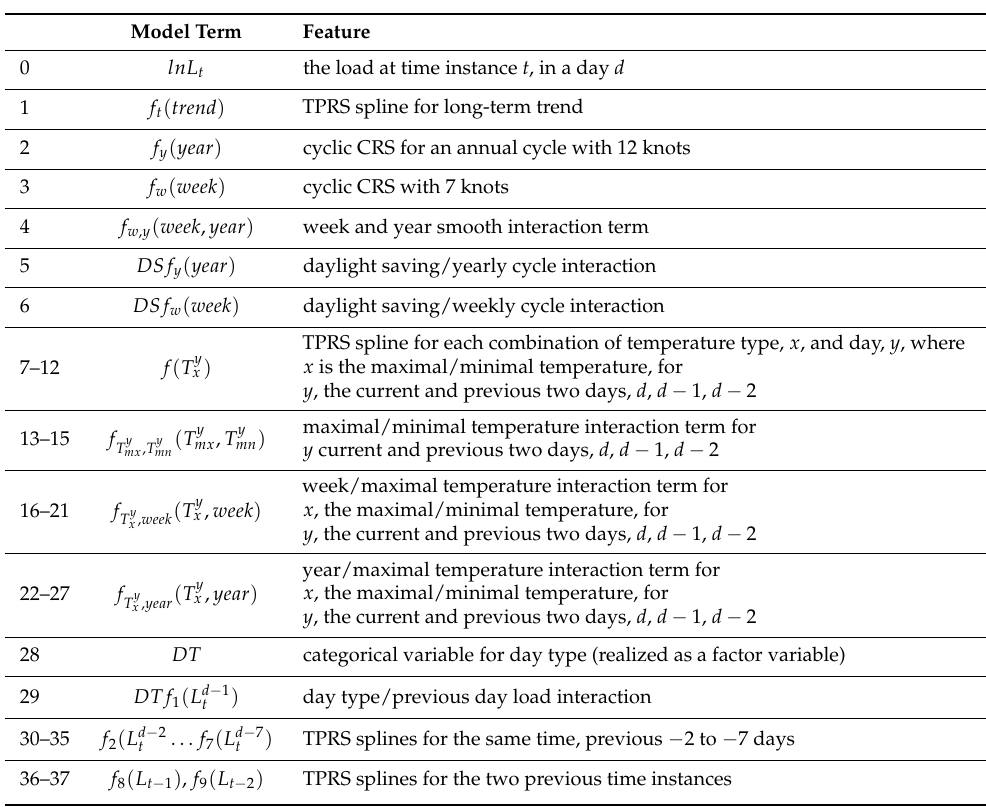
Table 2. Dictionary of GAM load